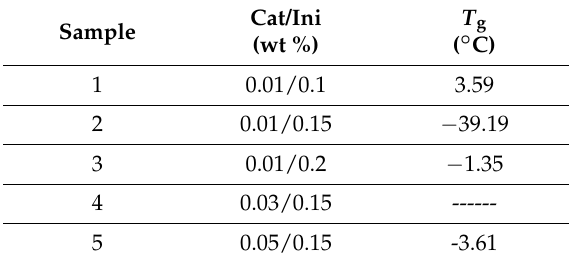
Table 1. Glass transition temperatures of PLA copolymers with different cat/ini